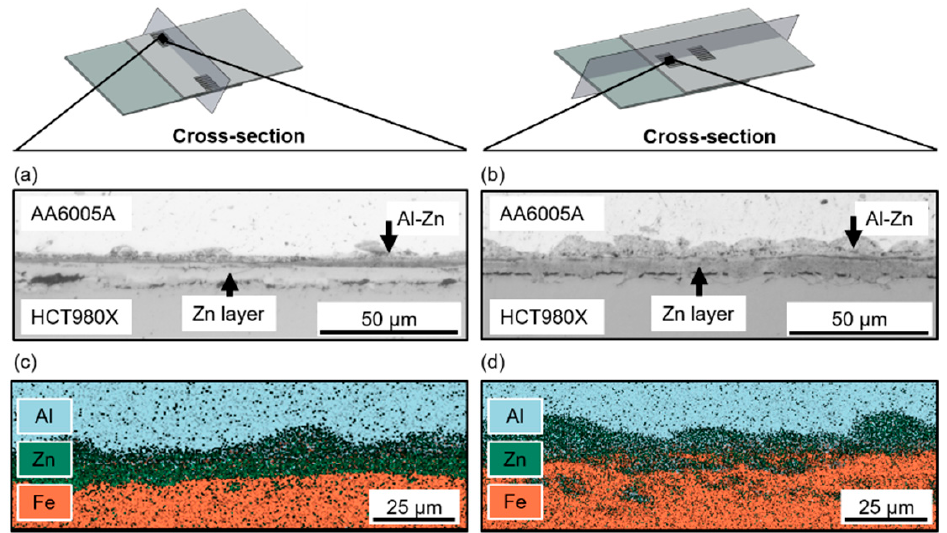
Figure 7. Optical micrographs and superimposed SEM/EDX maps of the Al/steel interfaces at welding spots for ( a , c ) parallel layout as well as ( b , d ) series layout. The fractured surfaces were characterized post-failure using EDX spot